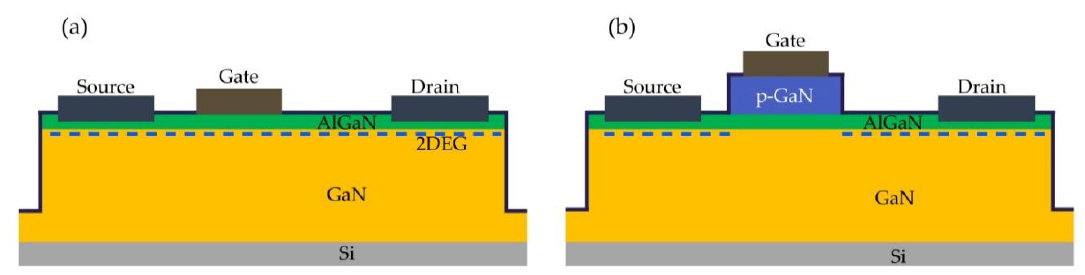
Figure 1. Structures of the GaN HEMTs, ( a ) the D-mode device and ( b ) the p-GaN E-mode device.